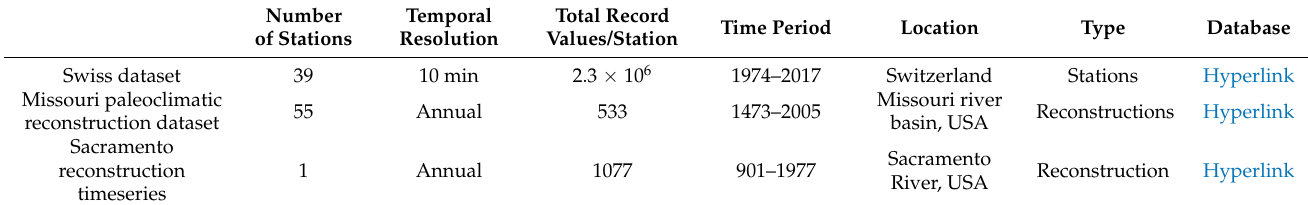
Table 1. Summary of used datasets for the stochastic analysis.